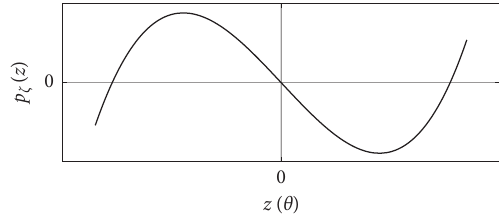
Figure 4: Qualitative graph of the force p